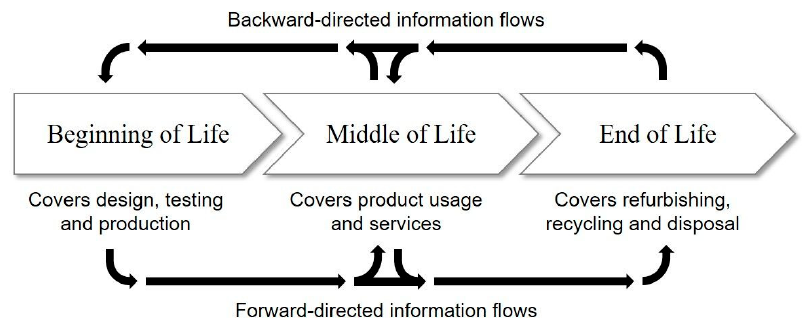
Figure 1. Phases and information flow of the product lifecycle [13].